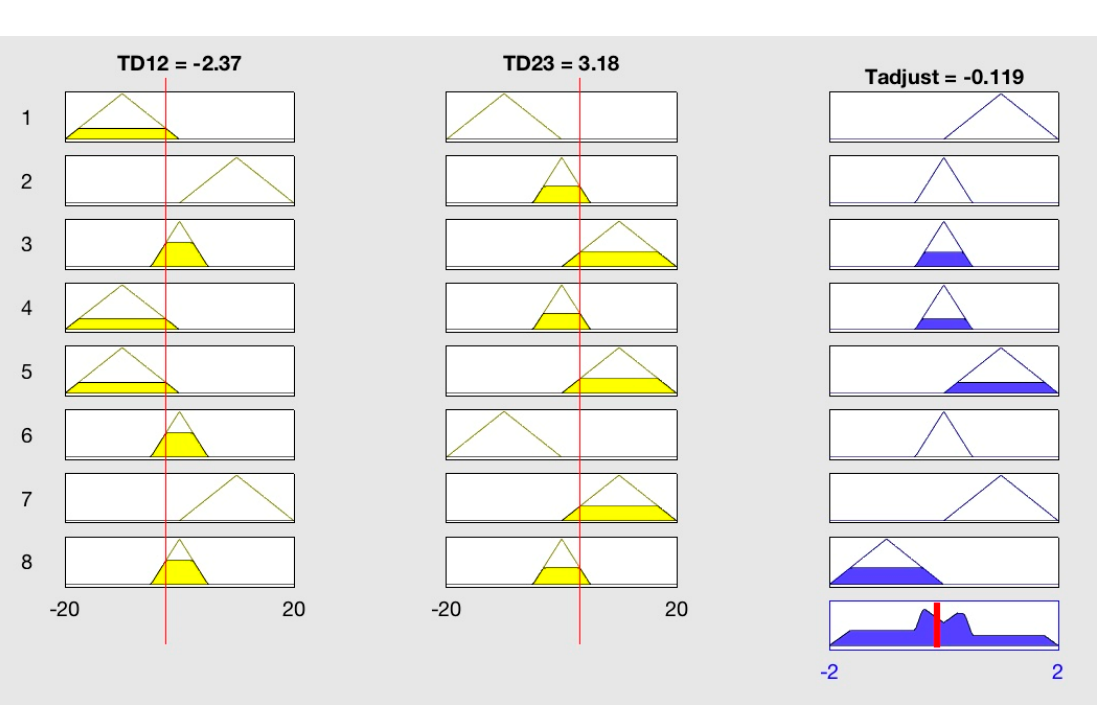
Figure 9. Visual process of input [ − 2.37, 3.18] in FLS for output T adjust.